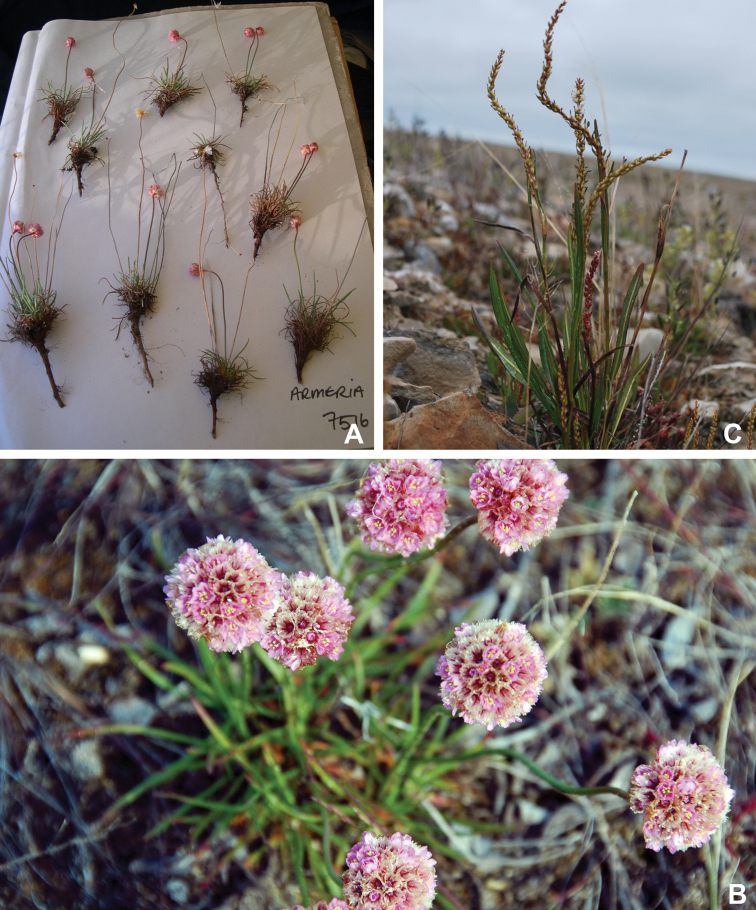
AArmeria
scabra plants ready to be pressed, Gillespie et al. 7516BArmeria
scabra habit CBistorta
vivipara habit. Photos A, C by R.D. Bull and B by B.A. Bennett.